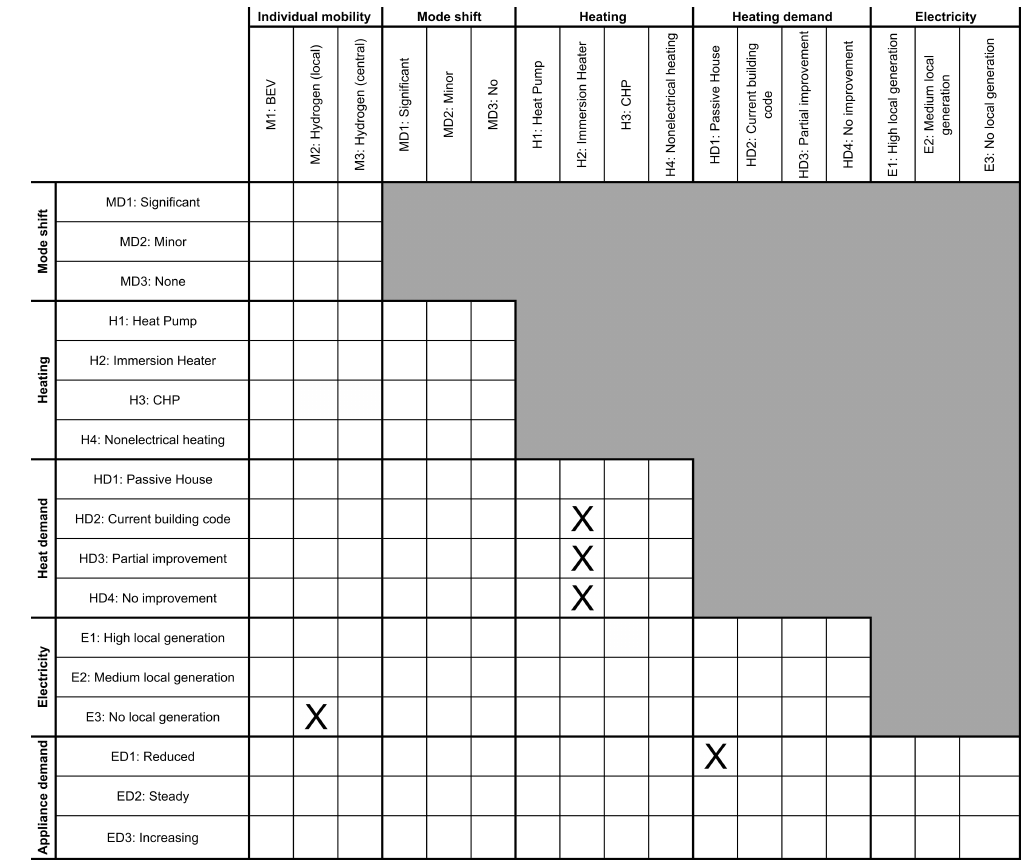
Figure 6. Cross-consistency matrix of the morphological box for the residential energy system.